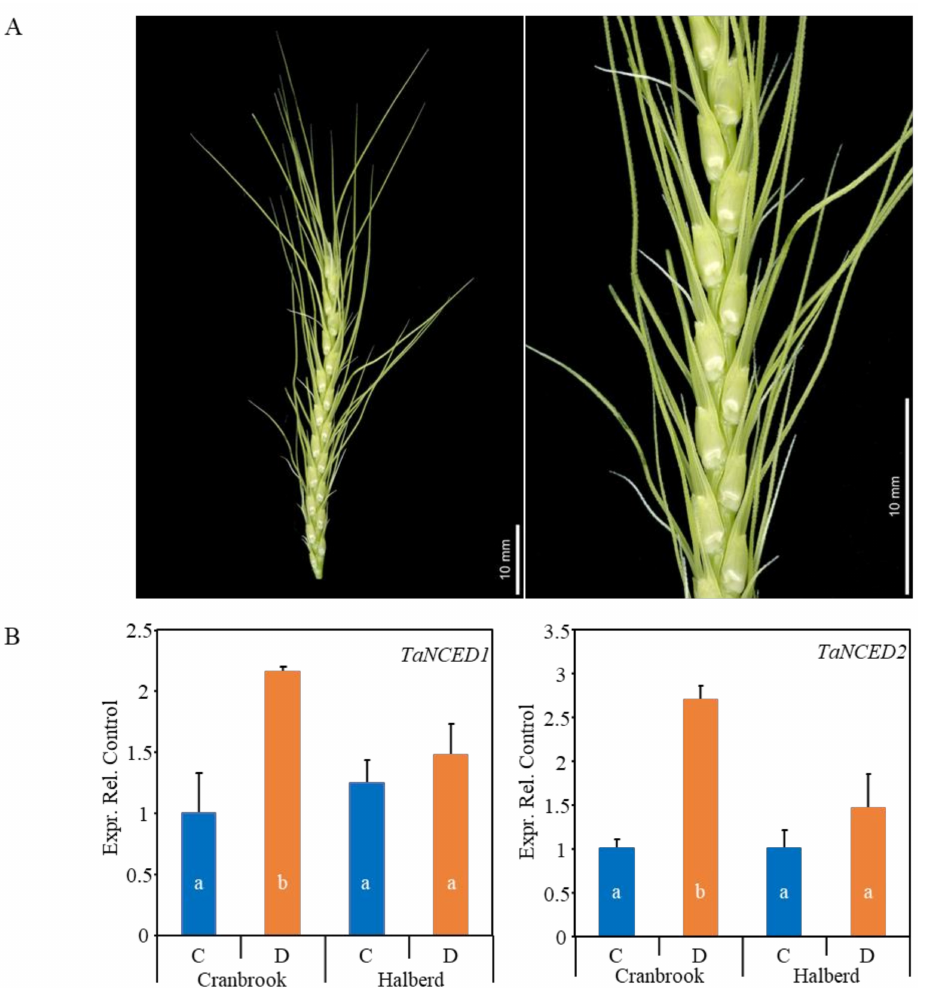
Figure 1. ( A ) The picture shows a YM stage wheat spike dissected from the leaf sheaths. The close-up and inset shows the spikelets and florets respectively at the time of pollen meiosis. Plants were drought-stressed at this stage and dissected spike material was used for transcriptome and hormone analysis. ( B ) Real-time PCR expression analysis of the wheat TaNCED1 and TaNCED2 ABA biosynthetic genes in unstressed control (C) and drought-stressed (D) Cranbrook and Halberd spikes. Each sample consisted of three repeats and error bars represent standard errors. Bars in the graph labelled with different letters are significantly different compared to the Cranbrook unstressed control (C) ( t -test; p <